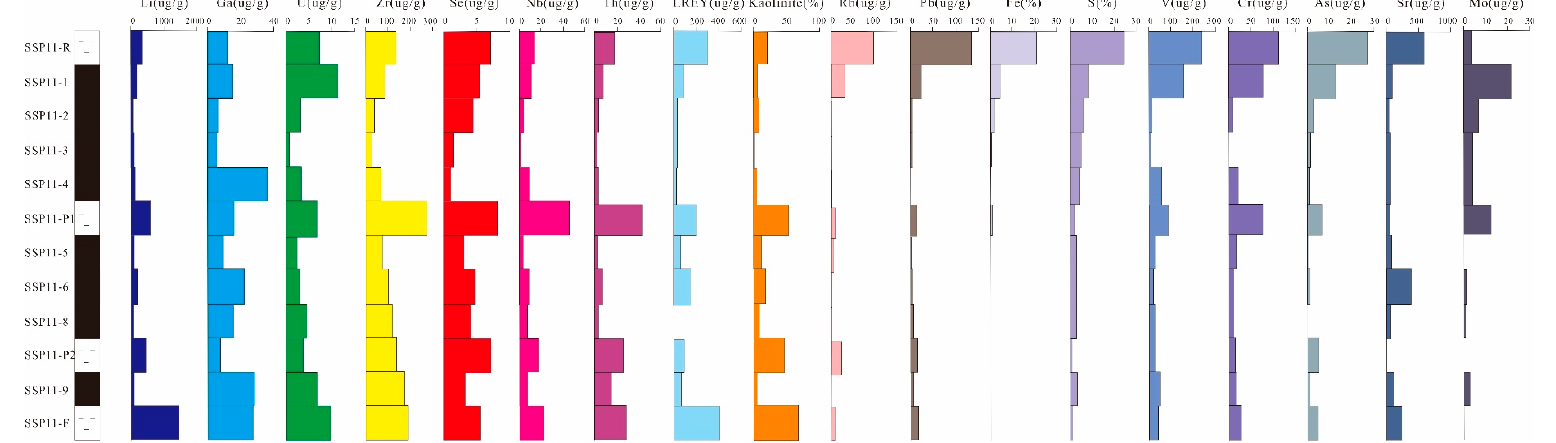
Figure 4. Vertical variation of concentrations of elevated elementsand kaolinite content in the No. 11 coal fromtheSangshuping coal mine.